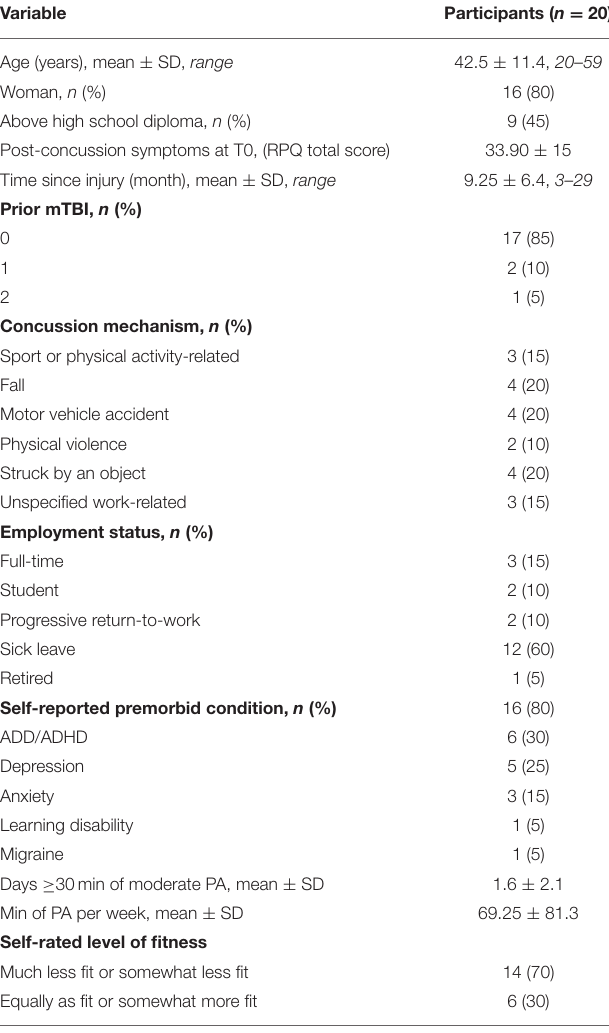
TABLE 1 | Demographic characteristics of participants receiving the telehealth progressive walking intervention ( n = 20).